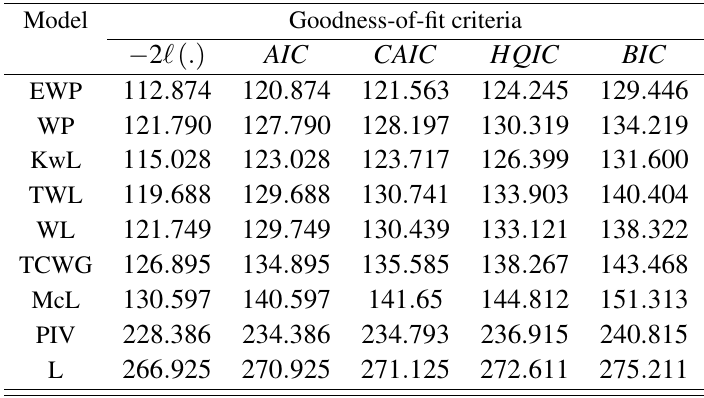
Table 3. The statistics − 2 ℓ , AIC ,CAIC, HQIC and BIC for carbon fiber data set Model